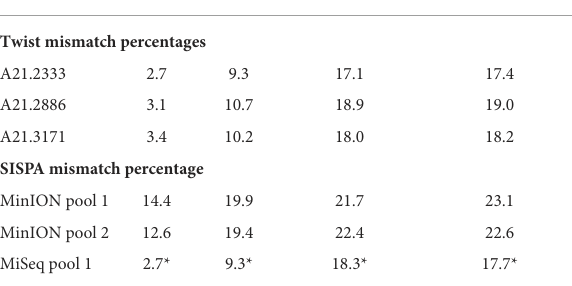
TABLE 3 Bioinformatics results of TWIST CVRP and SISPA sequencing